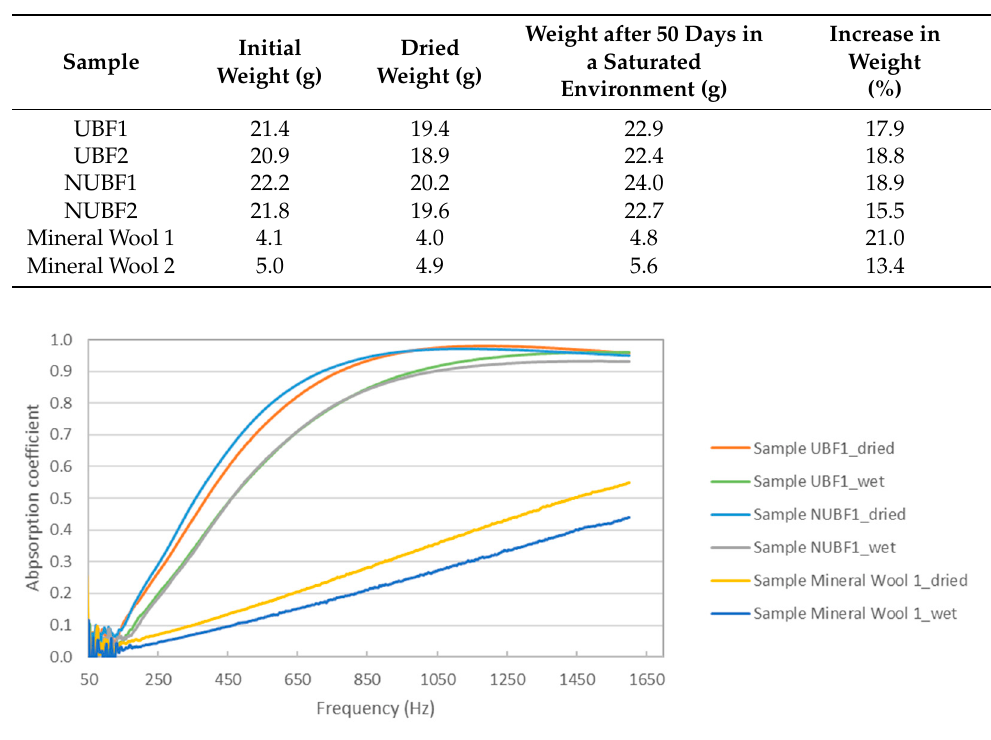
Figure 4. Variation in the absorption coefficient with the degree of humidity in the analyzed samples.